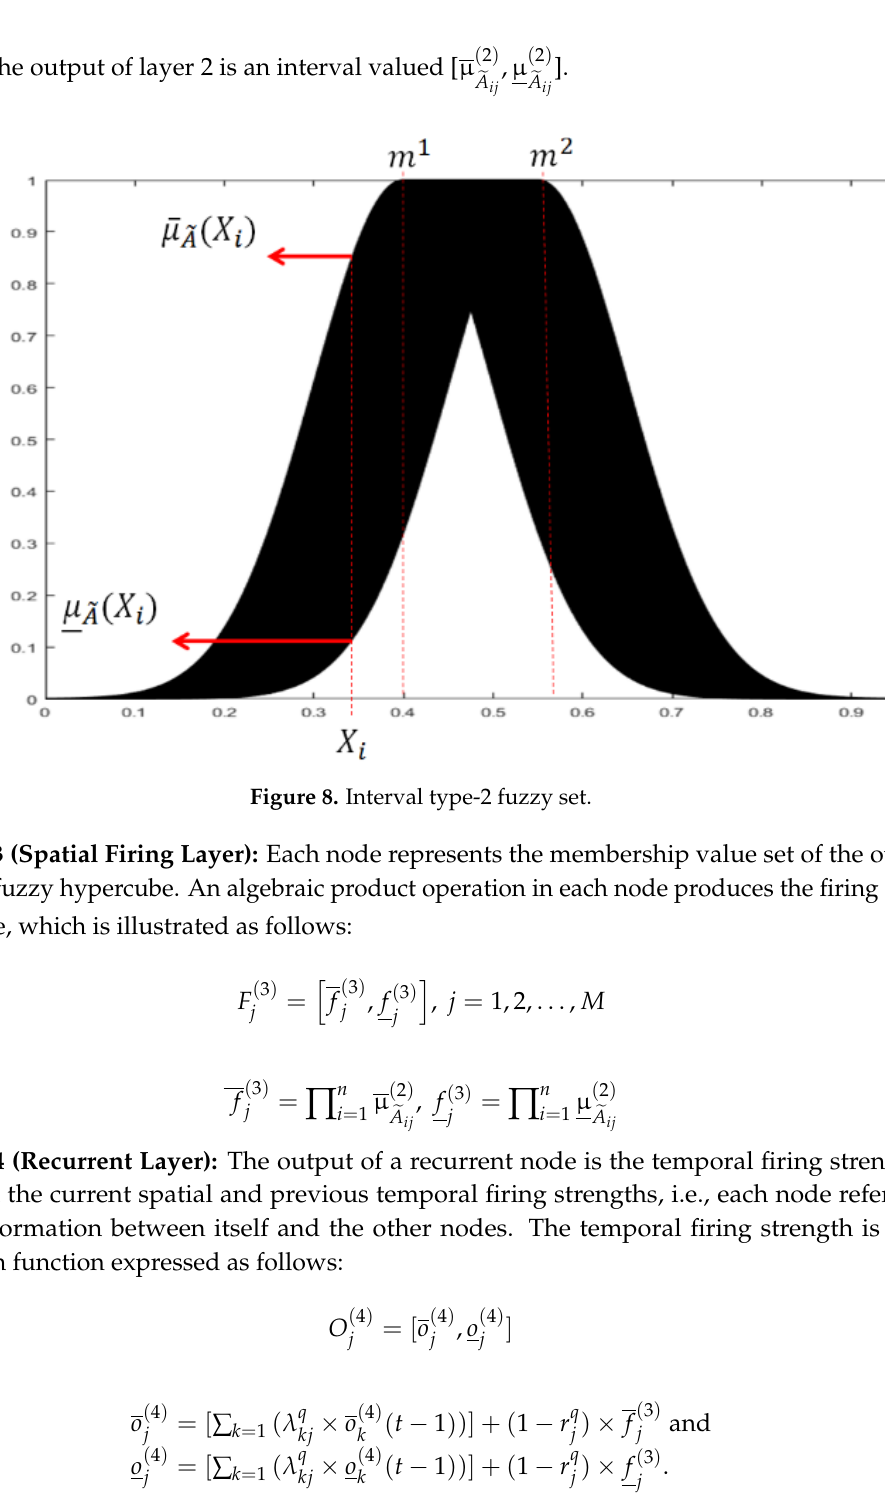
y Figure 7. Structure of T2FCMAC classifier. Layer 1 (Input Layer): The input data are imported into the next layer from this layer, and this includes only the transmission of information without any computation. 𝐼𝑛𝑝𝑢𝑡 𝑖(1) = 𝑋 𝑖 , 𝑎𝑛𝑑 𝑖 = 1,2, … 𝑛 (8) where n represents the input dimension.